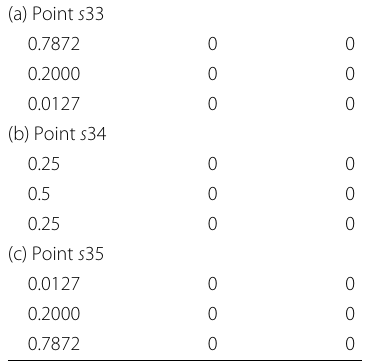
Table 4 Example two-patch model: shape function values N i ( ξ , η ) for the integration points s 33 − 35 (a) Point s 33